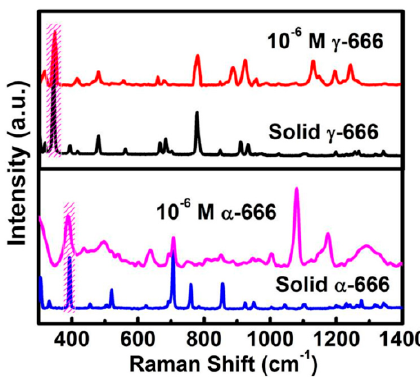
Figure 11. The Raman spectra of the pure solid γ -666 and α -666, and the SERS spectra of γ -666 and α -666 molecules on the chestnut-like Au nanocrystals’ film after soaking in 10 − 6 M solutions (excited at 785 nm).